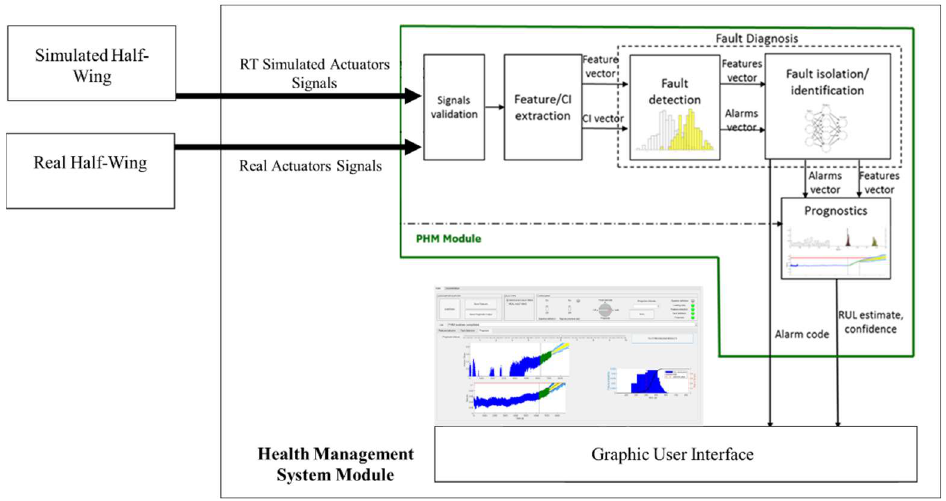
Figure 15. Architecture of the proposed PHM Framework.